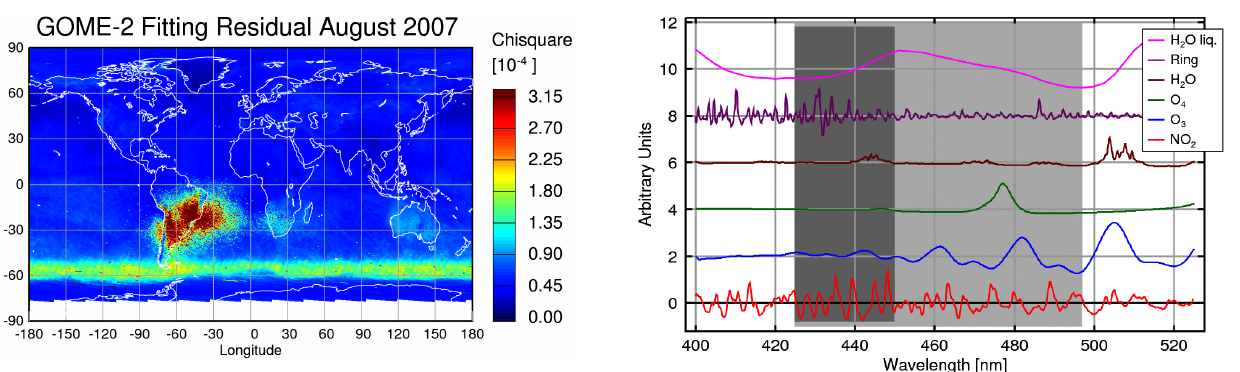
Fig. 5. Relevant differential absorption cross-sections in the spectral region used for the NO 2 retrieval. High pass filtering was applied by subtraction of a polynomial of degree 3 from all cross-sections. The standard fitting window is shown in dark grey; the larger range of the improved retrieval is indicated in light grey. The individual lines are offset for